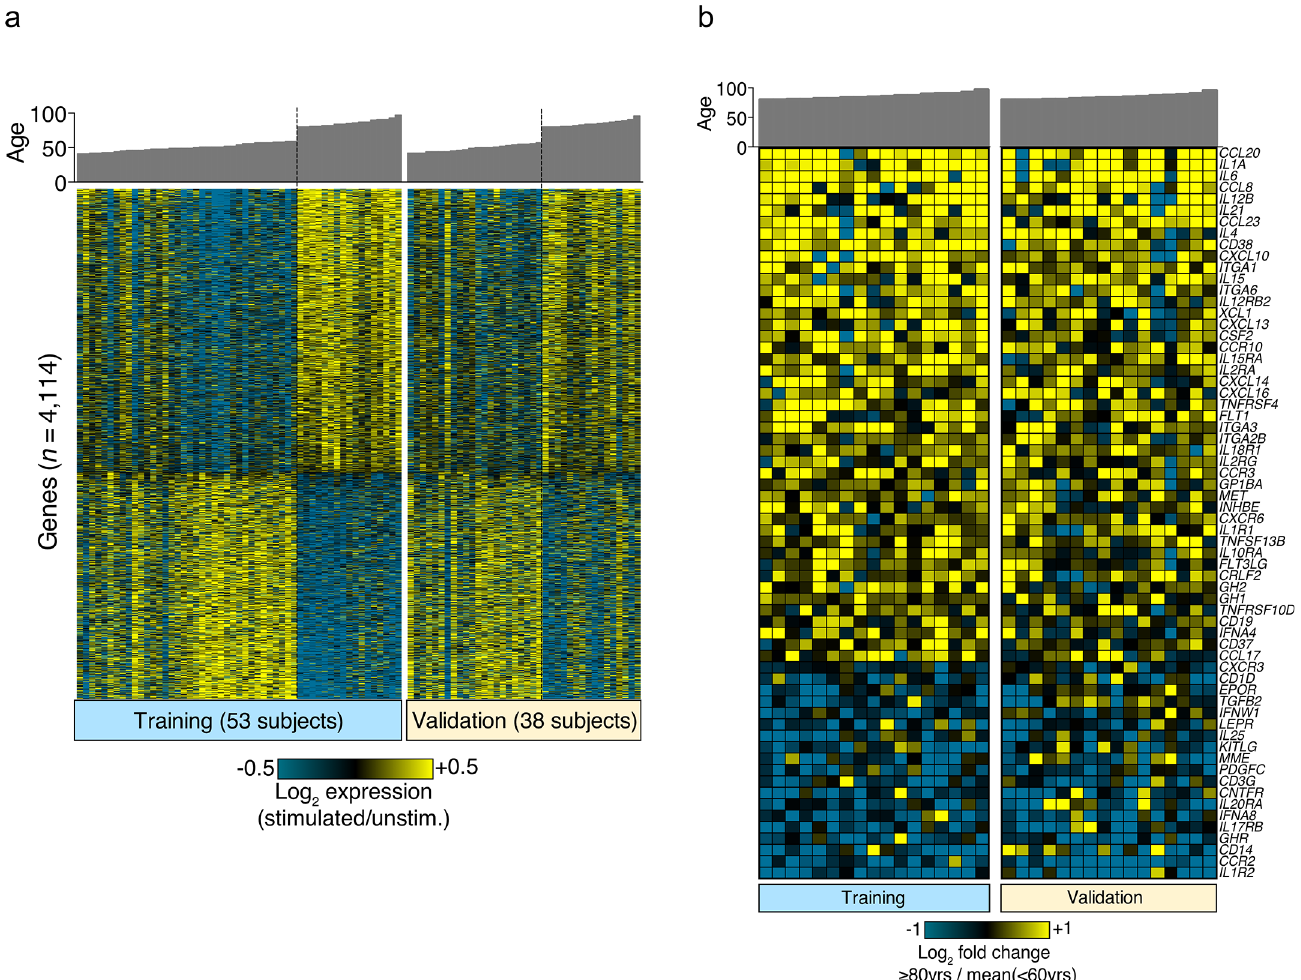
Fig 5. Differentially expressed genes by age in stimulated PBMC. After 4 hours incubation of PBMC with or without a cocktail of IFN α , LPS, CD3+CD28, and anti-IgM+IgG, RNA was extracted and used for gene expression microarray analysis (Agilent, 4x44K, 2-color). Subjects < 60 y and > = 80 y were randomly divided into a training set (53 subjects) and validation set (38 subjects). 4114 genes were identified in the training set as differentially expressed in the older vs. younger subset. (A) Differentially expressed genes are ordered by decreasing fold change between older and younger groups in the training set (left panel). A similar segregation is seen in the validation group (right panel). In these panels, expression values are represented as log2 expression (stimulated/unstimulated). (B) Display of 64 immune-related genes from the 4114 gene signature. In these panels, expression values are represented as fold change compared to the mean level of each gene in the young group. While many genes were associated with age, no gene signature was found to be specifically associated with CMV or sex (data not shown).